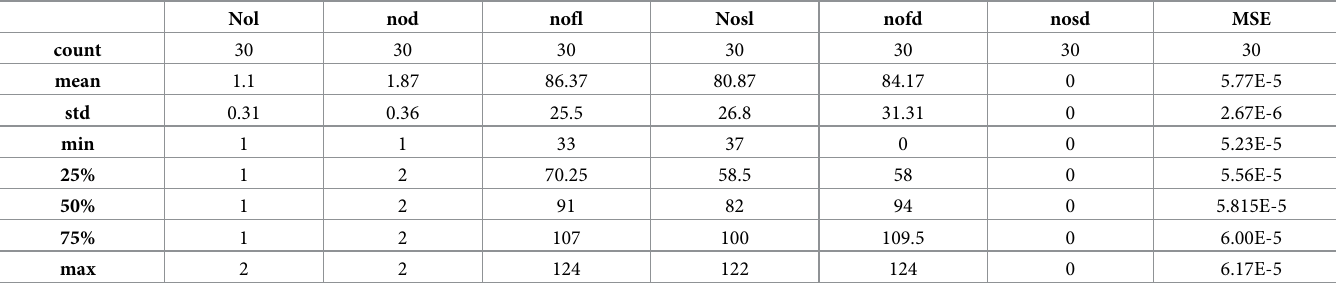
Table 6. Statistical description of 30 optimal parameter combinations.